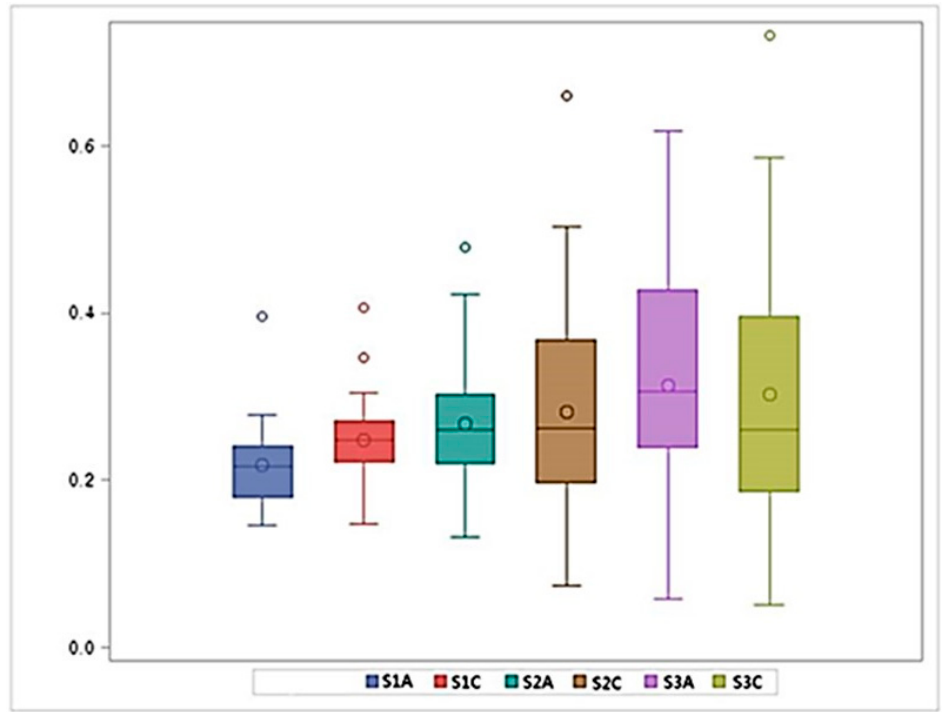
Figure 9. The narrowest canal width (mm).